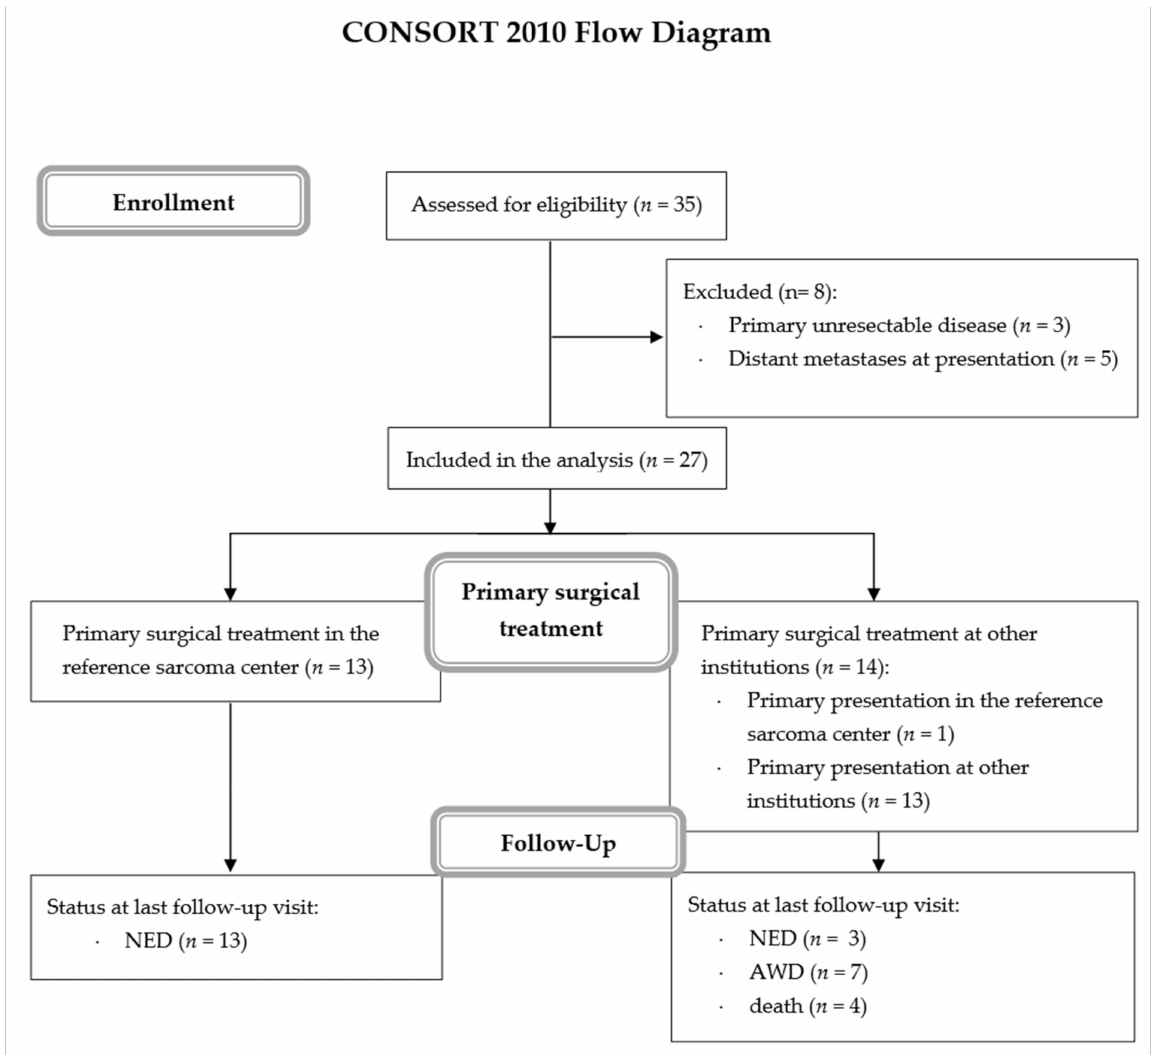
Figure 1. Treatment and follow-up of PEComa patients treated in Maria Sklodowska-Curie National Research Institute of